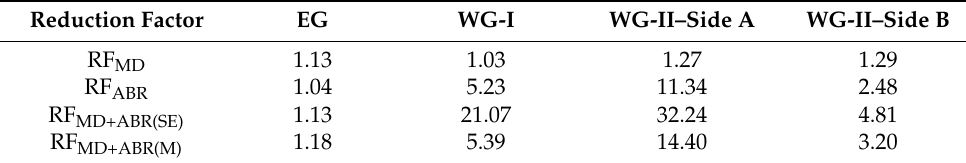
Table 4. Reduction factors for the tensile strength of the